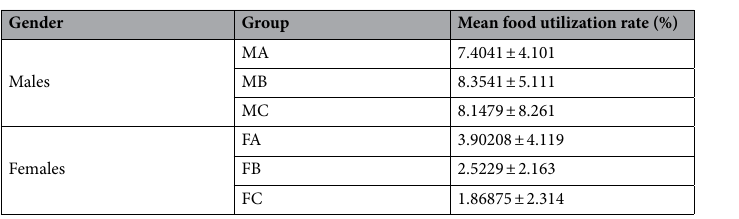
Table 1. Mean Food utilization rate (%) after feeding with different diets for 90 days in the studied groups. Data are reported as mean ± SD. MA: male rats with Tarom molaii rice feeding, MB: male rats with GM Bt rice feeding, MC: male rats with standard feeding, FA: female rats with Tarom molaii rice feeding, FB: female rats with GM Bt rice feeding, FC: female rats with standard feeding.